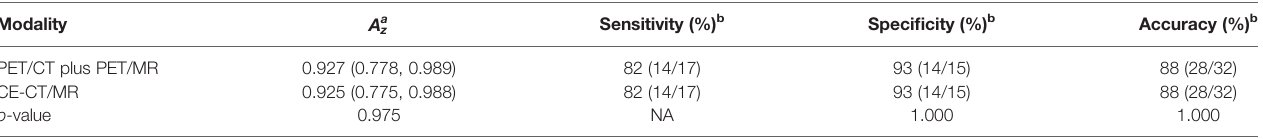
TABLE 2 | Diagnostic performance of PET/CT plus delayed PET/MR imaging and CE-CT/MR imaging in the assessment of tumor resectability. Modality A a z Sensitivity (%) b Speci fi city (%) b Accuracy (%) b PET/CT plus